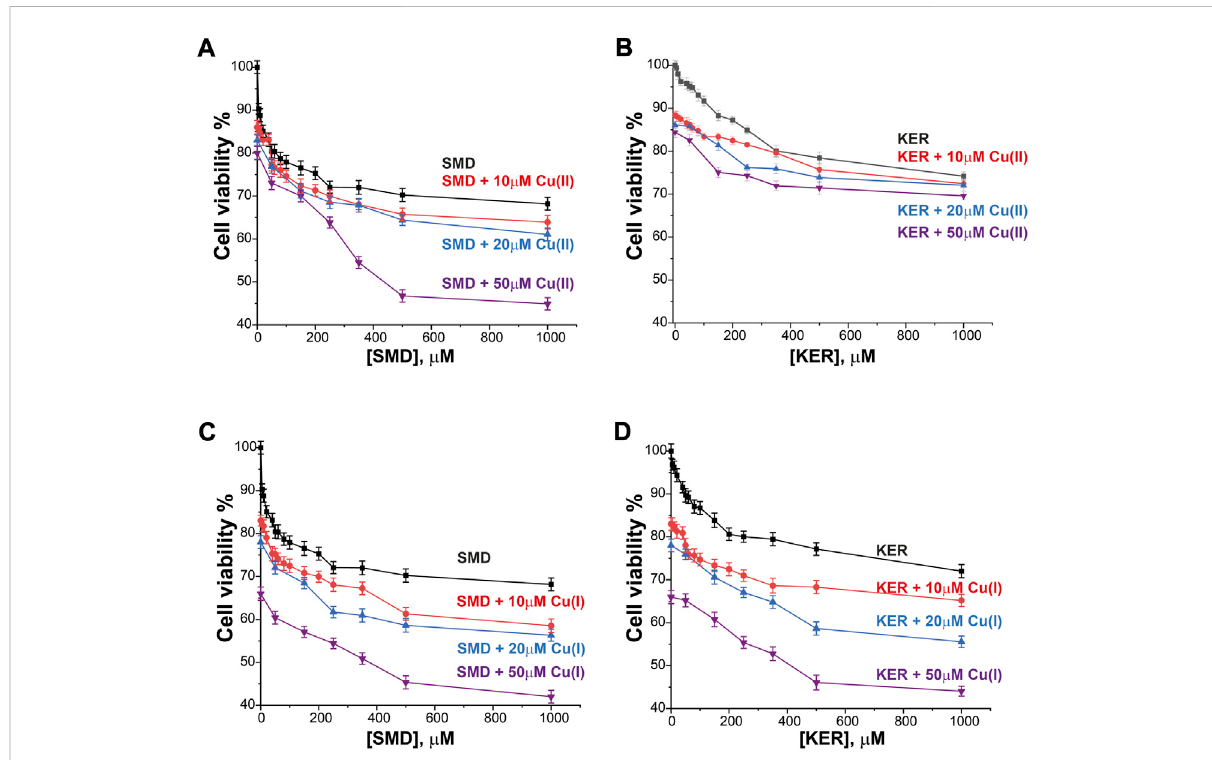
FIGURE 6 HepG2 liver cancer cell viability in the presence of SMD peptide at varying Cu(II) and Cu(I) concentrations in (A) and (C) , respectively, and in the presence of KER peptide and varying Cu(II) and Cu(I) concentrations in (B) and (D) , respectively. At [peptide] = 0, cell viability valuein thepresence of [Cu(II)/Cu(I)] is given. Error bars were calculated based on three independent